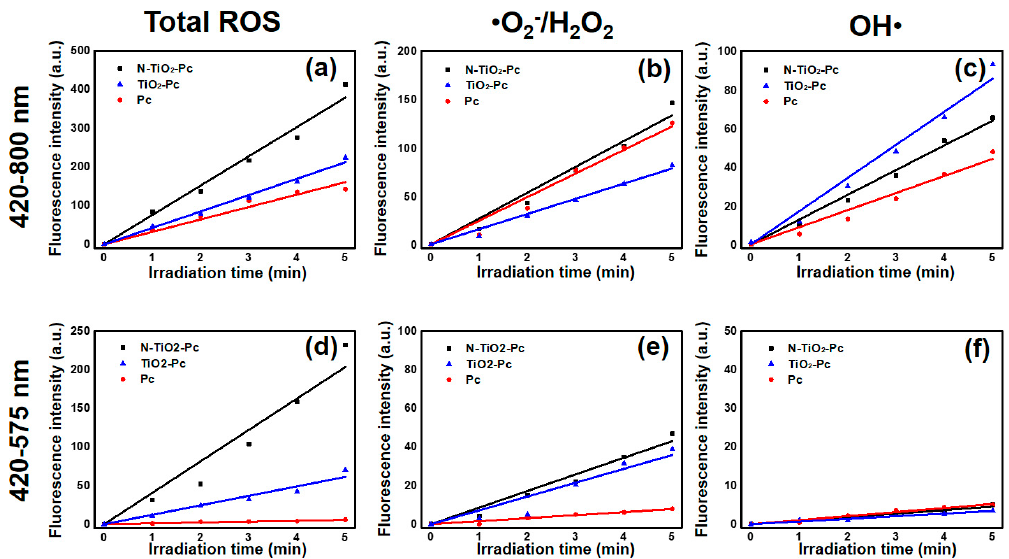
Figure 2. Comparison of photo-induced reactive oxygen species (ROS) by N-TiO 2 -Pc, TiO 2 -Pc, and Pc in aqueous solutions under light irradiation of ( a – c ) 420–800 nm (17.8 mW · cm − 2 ) and ( d – f ) 420–575 nm (8.4 mW · cm − 2 ), where the concentration of Pc is the same in all three samples. Fluorescence intensities indicate the production of ( a , d ) total ROS, ( b , e ) • O 2 − /H 2 O 2 , and ( c , f ) OH • as a function of irradiation time.